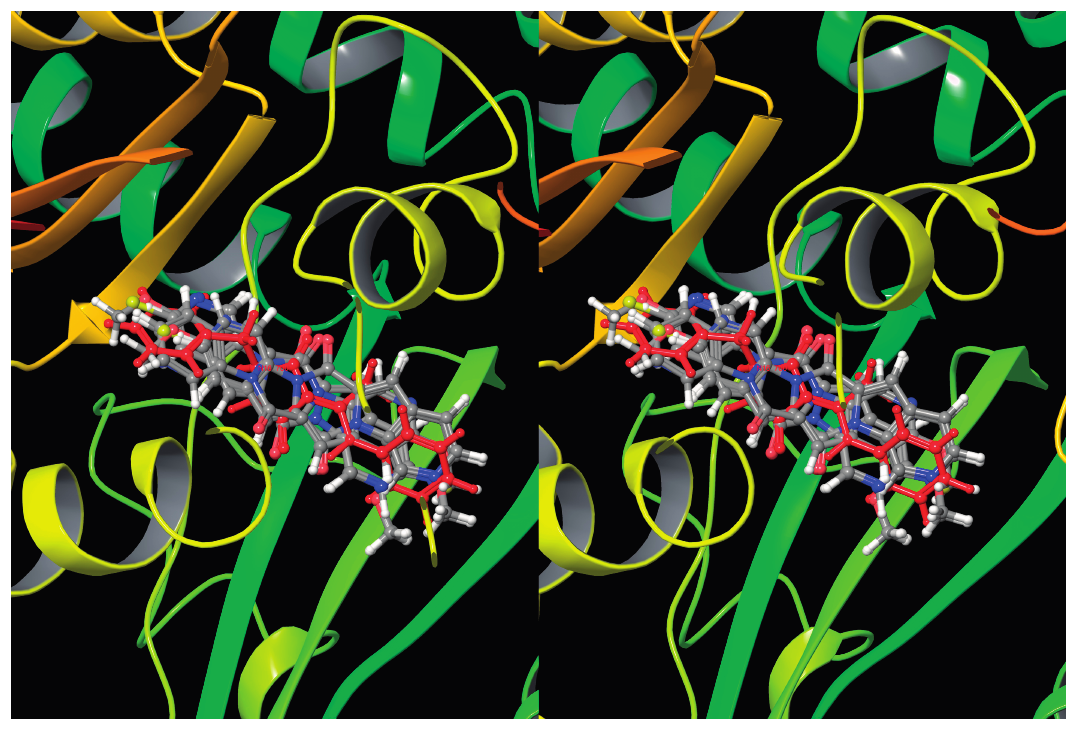
Figure 2. Wall eyed superimposition of compounds 4a – d , 5a – e and 6a – d with TN-16